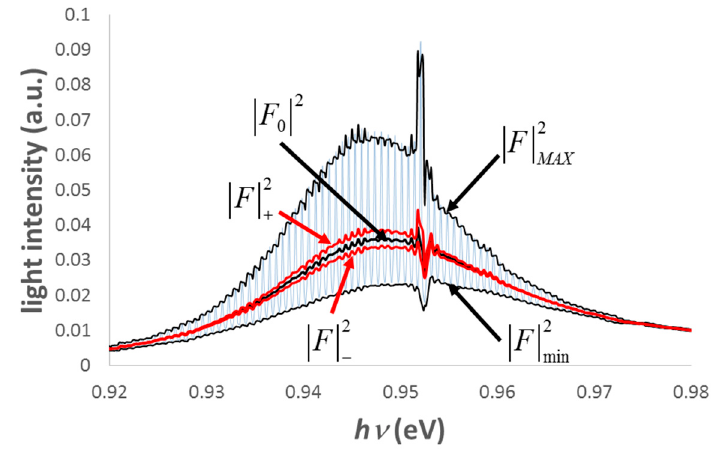
Figure 3. An experimental spectrum from a DFB laser diode with a Fabry–Perot cavity, with the relevant curves for the Hakki–Paoli, Cassidy, or Vanzi methods. The mathematical expression of each curve is given in Equation (18), and follows the definition of | F | 2 in Equation (17). All curves are calculated from experimental data. The three methods share the same approach of calculating the ratio of a pair of those curves, in order to eliminate the | F 0 | 2 term. They differ from each other in the choice of the specific pair of curves. The benefits of replacing | F | 2 in the Hakki–Paoli method with the function | F | 2 + is one of the valuable points of the Cassidy method.